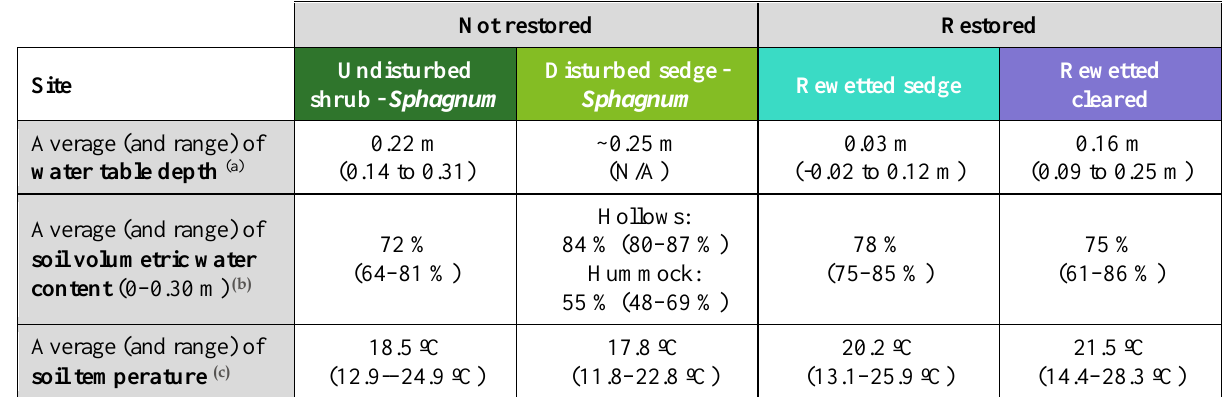
(a) Depth of water table below surface measured by piezometers, negative values denote standing water above surface. (b) Integrated measurement over top 0.30 m using two TDR probes. All sites except the disturbed sedge - Sphagnum site report the average of the two probes. At the disturbed sedge - Sphagnum site, the distinct microtopography causes two water content régimes. (c) Averaged over two soil thermocouples installed at 0.05 m